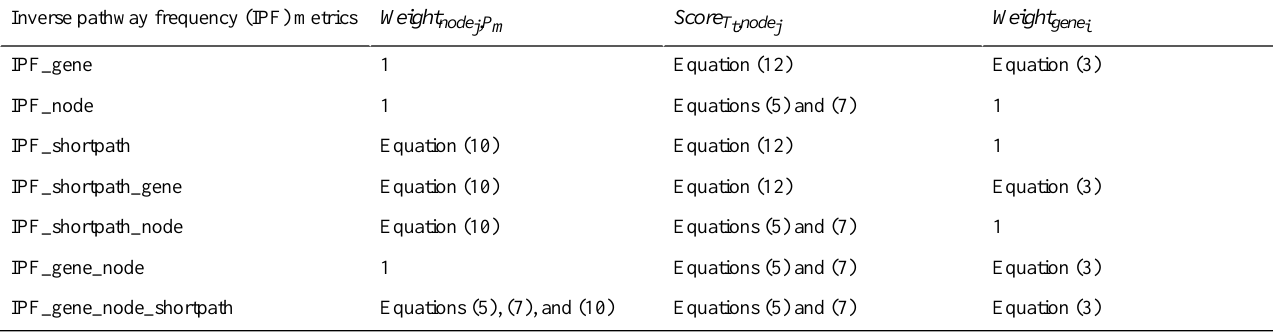
Table 1. The complete inverse pathway frequency metrics